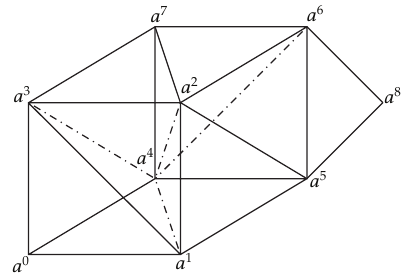
Figure 6: A simplicial complex model with all cells.